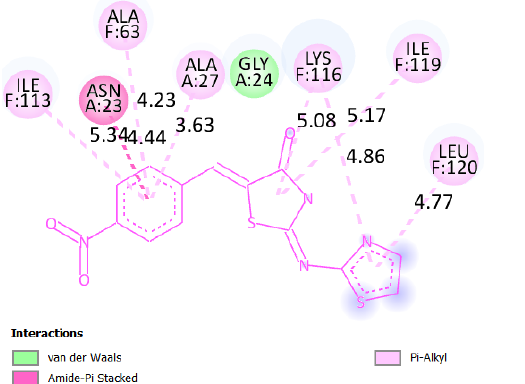
8 of 14 Figure 2. 2D and 3D binding mode of Les-6222 with 5-LOX. According to molecular docking studies, Les-6222 has a pronounced affinity for